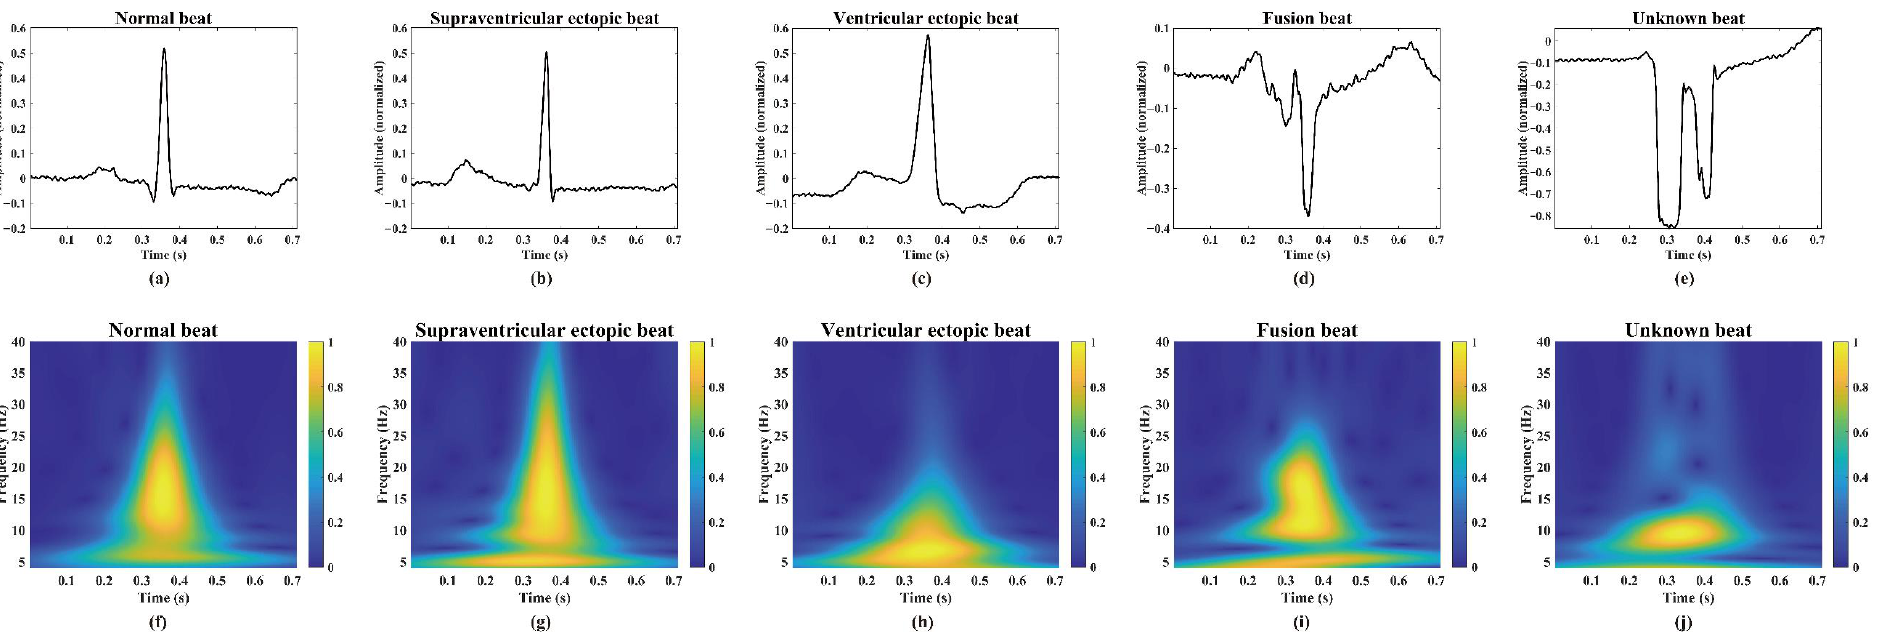
Figure 2. ECG signal of the QRS complex of ( a ) normal, ( b ) ventricular ectopic, ( c ) supraventricular ectopic, ( d ) fusion, and ( e ) unknown beats, and the CWT of the QRS complex of ( f ) normal, ( g ) ventricular ectopic, ( h ) supraventricular ectopic, ( i ) fusion, and ( j ) unknown beats.